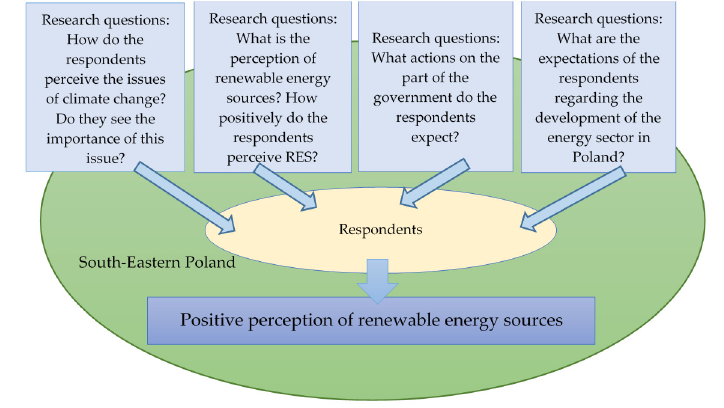
Figure 1. TOC-graph of the